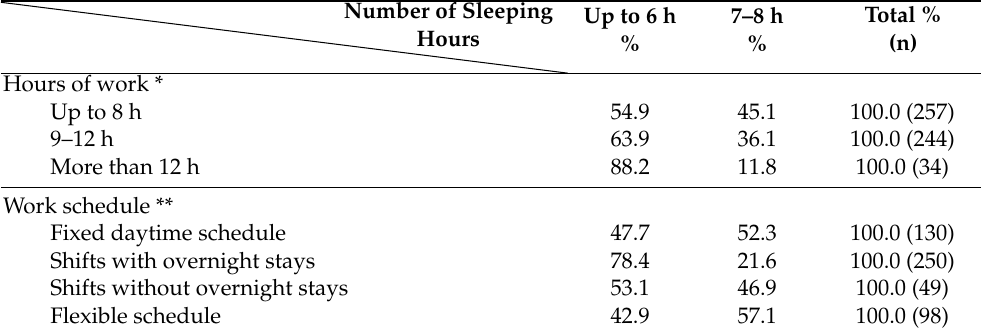
Table 4. Number of hours of sleep per day on working days, by number of hours of work per day and work